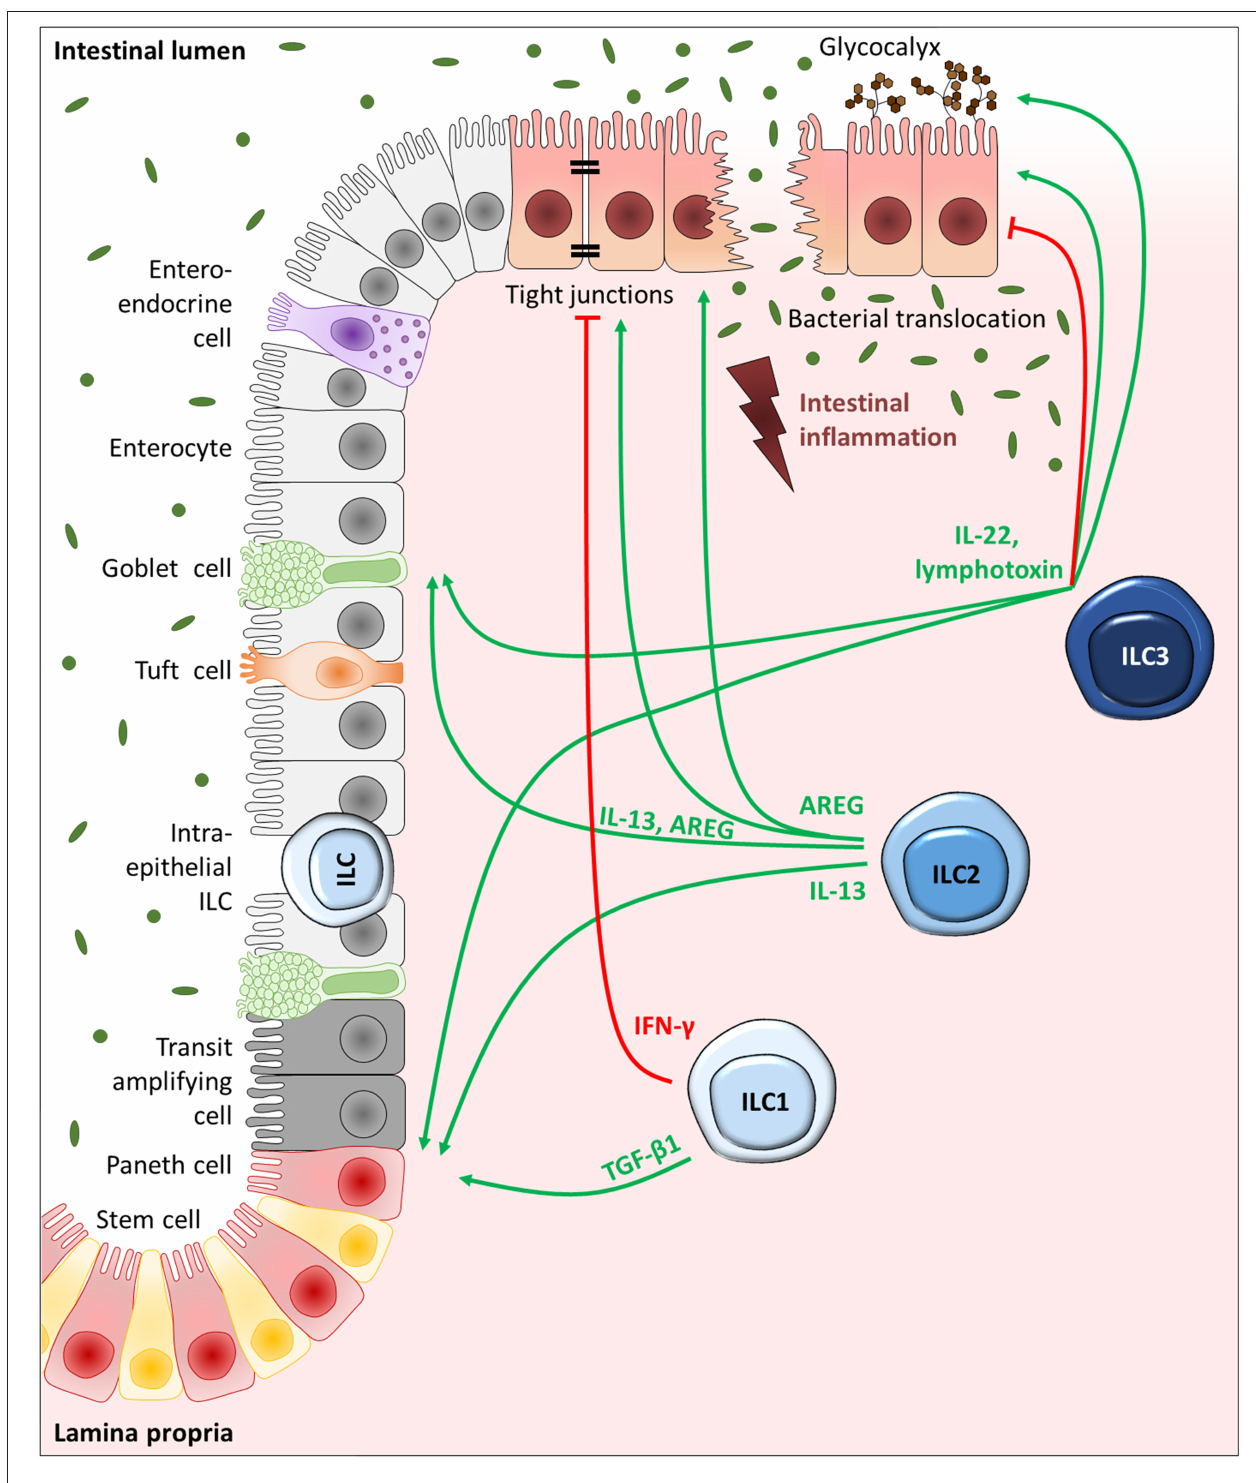
FIGURE 2 | ILC-driven regulation of IECs in intestinal inflammation. Schematic depiction of the intestinal epithelium, consisting of goblet cells, tuft cells, enteroendocrine cells, and M cells dispersed throughout the enterocytes as well as transit-amplifying progenitor cells, paneth cells, and stem cells localized toward the crypt bottom. ILC1s, ILC2s, and ILC3s reside in the mucosa in close proximity to the epithelium or can be directly positioned in between IECs as intraepithelial ILCs, giving them prime positions to interact with IECs. While IECs are important activators of ILCs via the release of selective alarmins, ILCs can in return control the